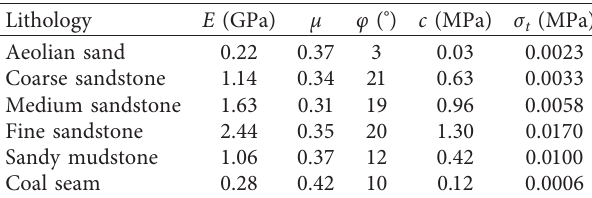
Table 4: Mechanic parameters of coal seam and rock